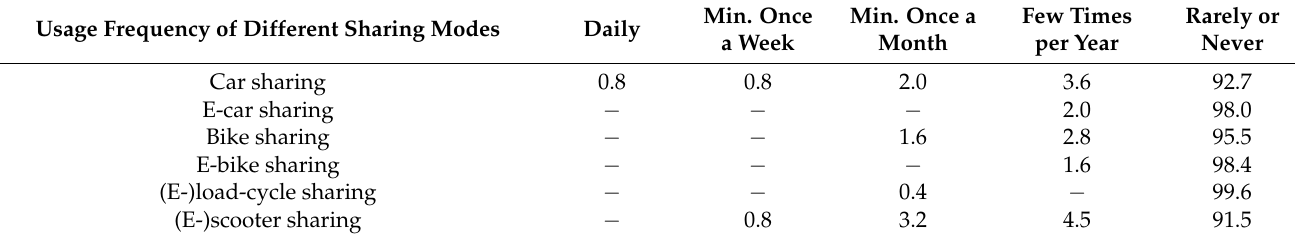
Table A5. Summary table for usage frequency of different sharing modes (% of the respondents). Usage Frequency of Different Sharing Modes Daily